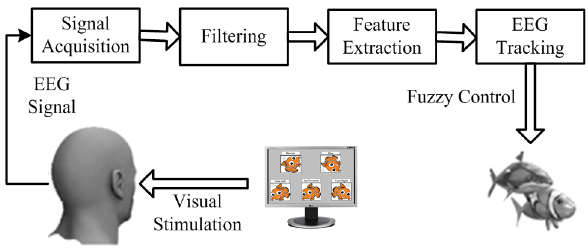
Figure 1. Brain-computer interface (BCI) remote control system architecture.